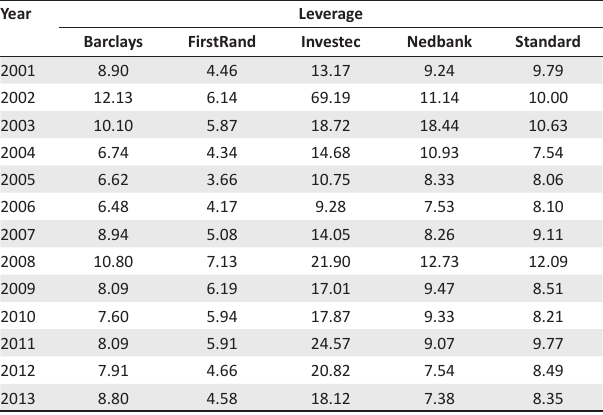
TABLE 2: Leverage of each South African bank.